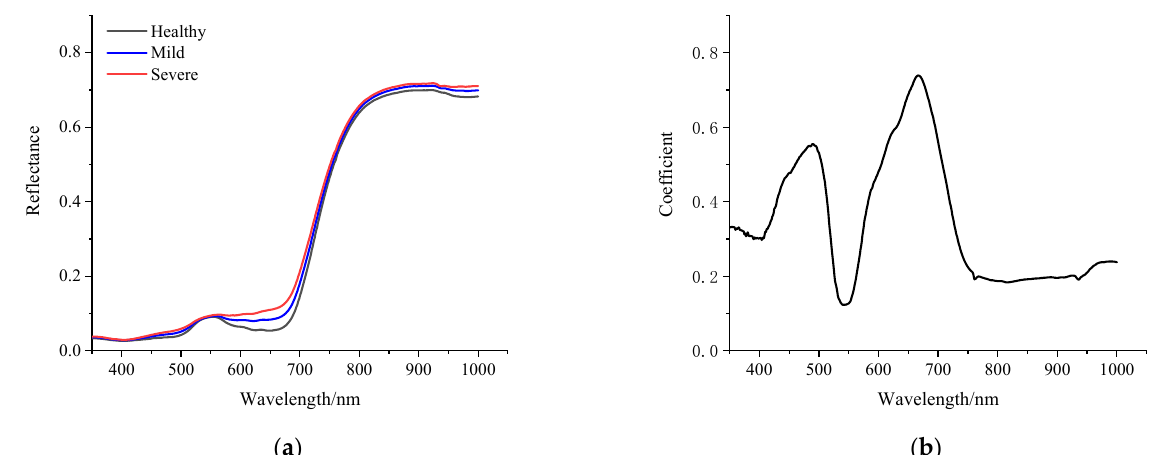
Figure 5. Reflectance spectrum and correlation curve of normal and diseased samples of wheat ear: ( a ) reflectance spectrum of healthy, mild and severe wheat ear samples (350–1000 nm) and ( b ) correlation coefficient between reflectance and disease severity.